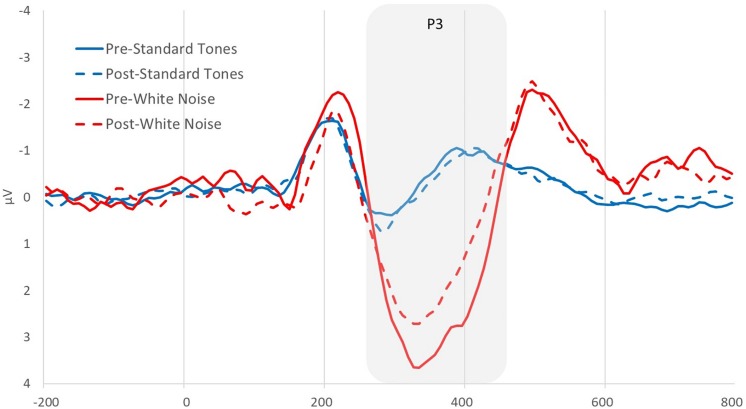
Pre- and post-picture viewing manipulation grand average event-related potentials (ERPs) at electrode F4 for standard tones and white noise stimuli.